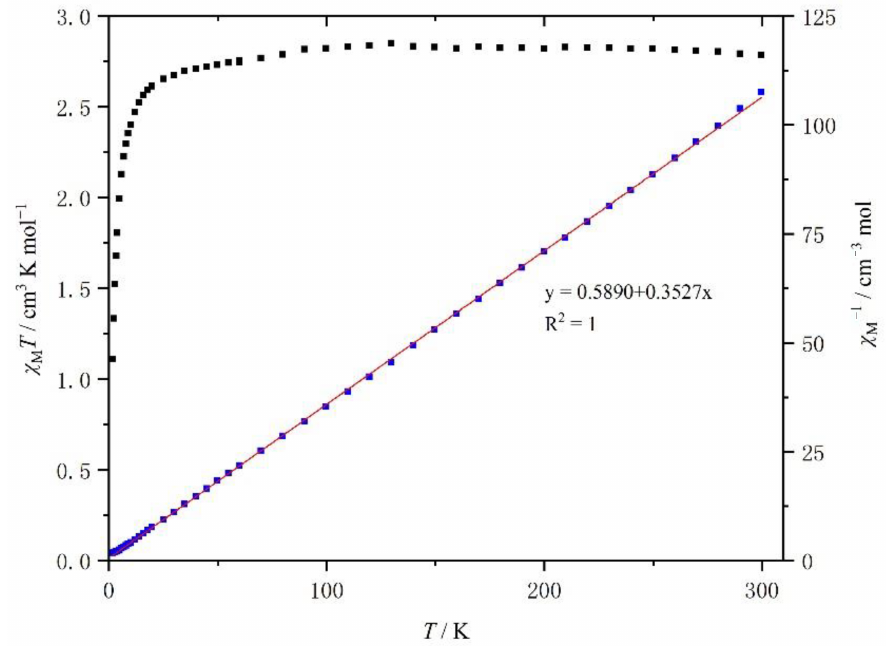
Figure 7. Hirshfeld surface mapped with d norm ( a ); 2D fingerprint plots of H···O for [Mn(4-OC 6 H 13 -sal-N-1,5,8,12)]NO 3 ·H 2 O ( b ).